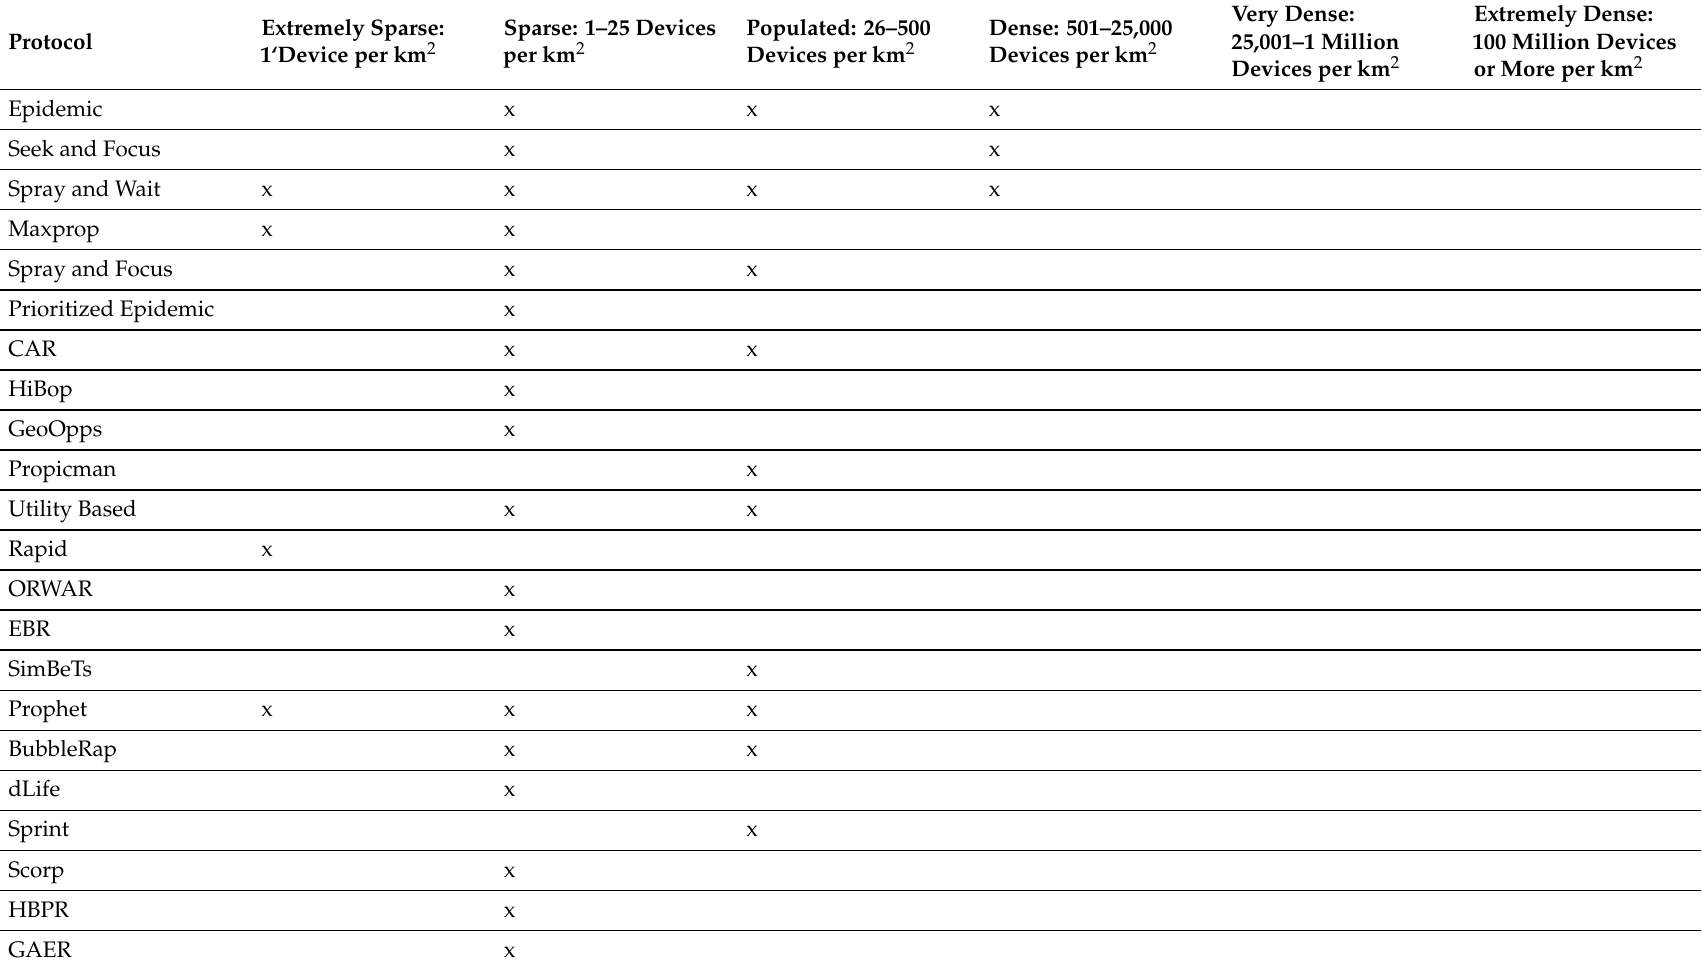
Table 2. Node densities for studied protocols (missing protocols do not provide enough